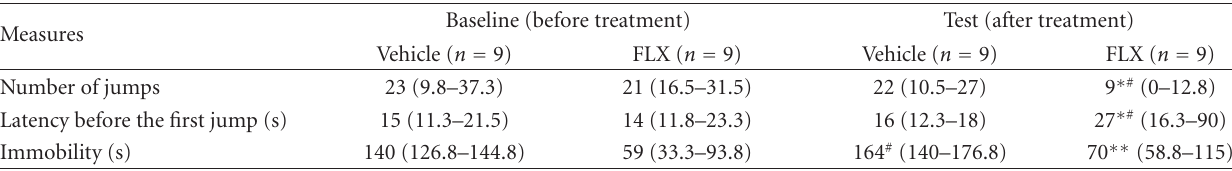
Table 1: E ff ects of subchronic fluoxetine (FLX) treatment (5mg/kg/21 d, IP, n = 9, median with limits of interquartile range values). Mann-